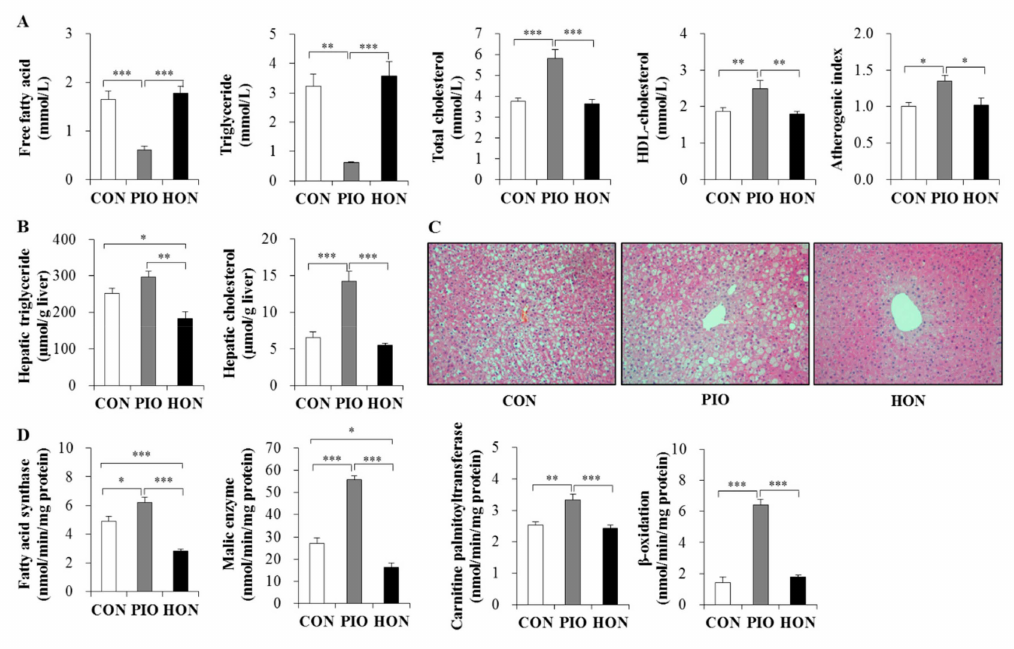
Figure 3. E ff ect of dietary HON on plasma lipid levels ( A ), hepatic lipid content ( B ), hepatic morphology ( C ), and hepatic lipid-regulating enzyme activity ( D ) in db / db mice. Male C57BL / KsJ- db / db mice were fed a normal diet with or without HON (0.02%, w / w ) or PIO (0.01%, w / w ) for 5 weeks ( n = 10 per group). ( A , B , D ): Data are presented as mean ± SE. * p < 0.05, ** p < 0.01, *** p < 0.001. ( C ): Hepatic lipid droplet accumulation in fixed transverse liver sections stained with H&E. Original magnification ×